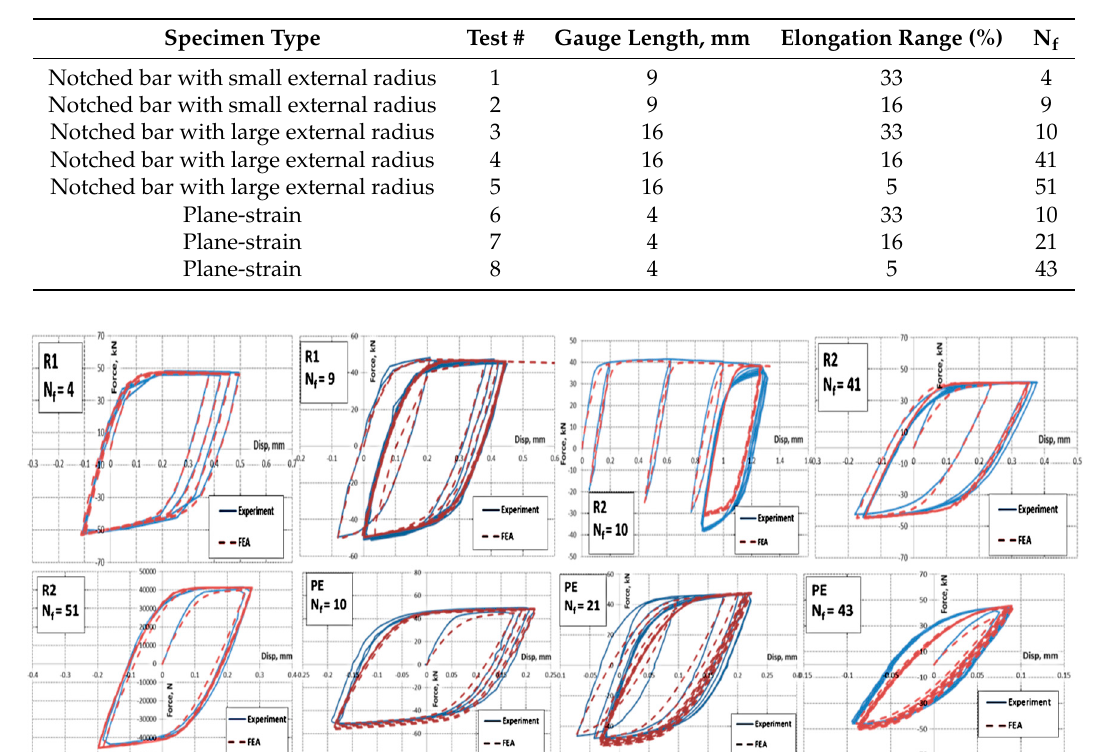
Table 6. Test data and strain measurements.